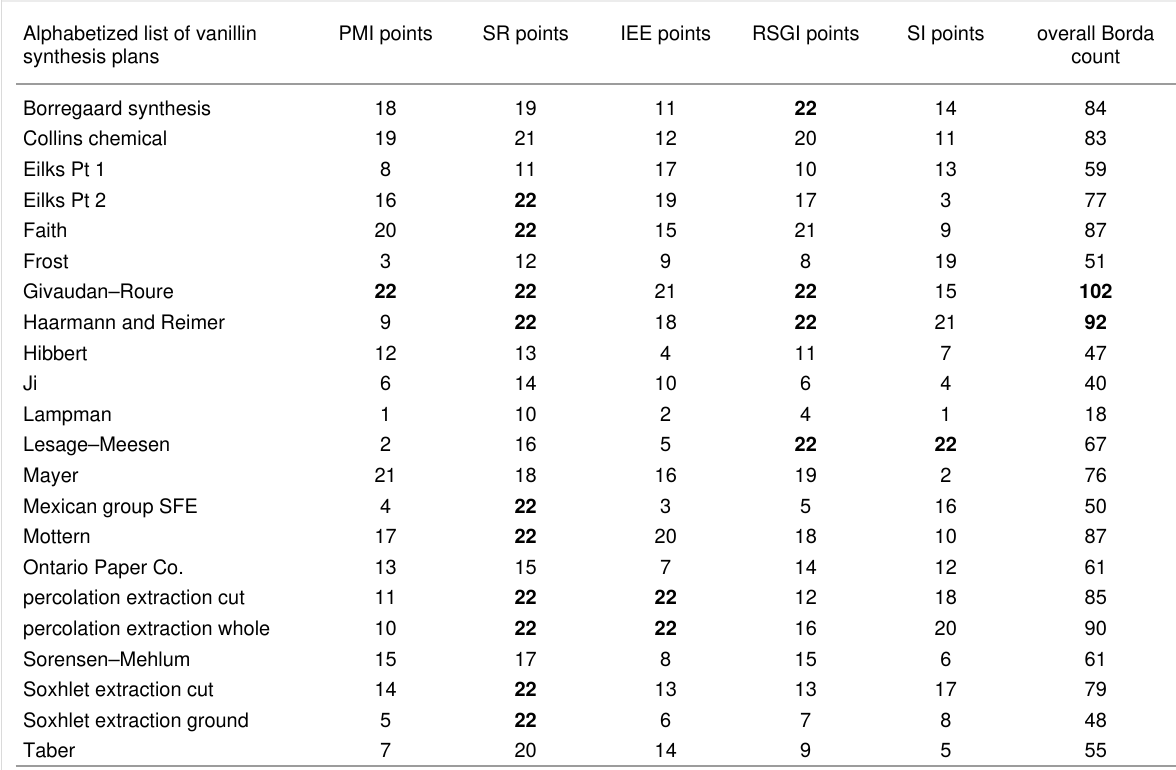
a Entries highlighted in bold represent the highest scores in each of the 5 attribute